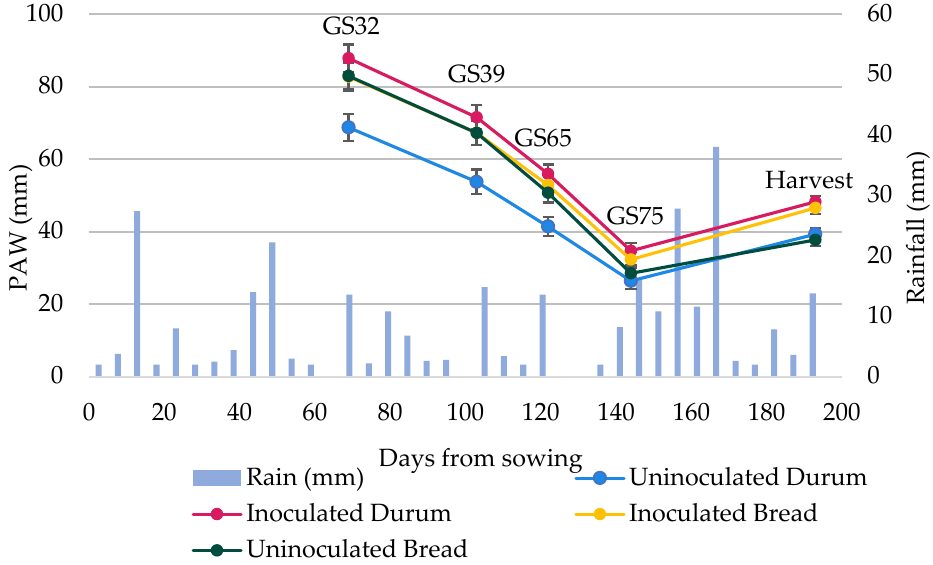
Figure 3. Plant available water (PAW) at Piallamore trial site (2020) measured through neutron probes between 30–150 cm depth indicated by lines of three bread (LRPB Lancer, Suntop and LRPB Hellfire) and three durum (DBA Lillaroi, Jandaroi and DBA Aurora) wheat varieties under both inoculated and uninoculated Fusarium crown rot treatments. Error bars indicate standard error. Rainfall (>2 mm) indicated by columns. Piallamore trial site 2020.